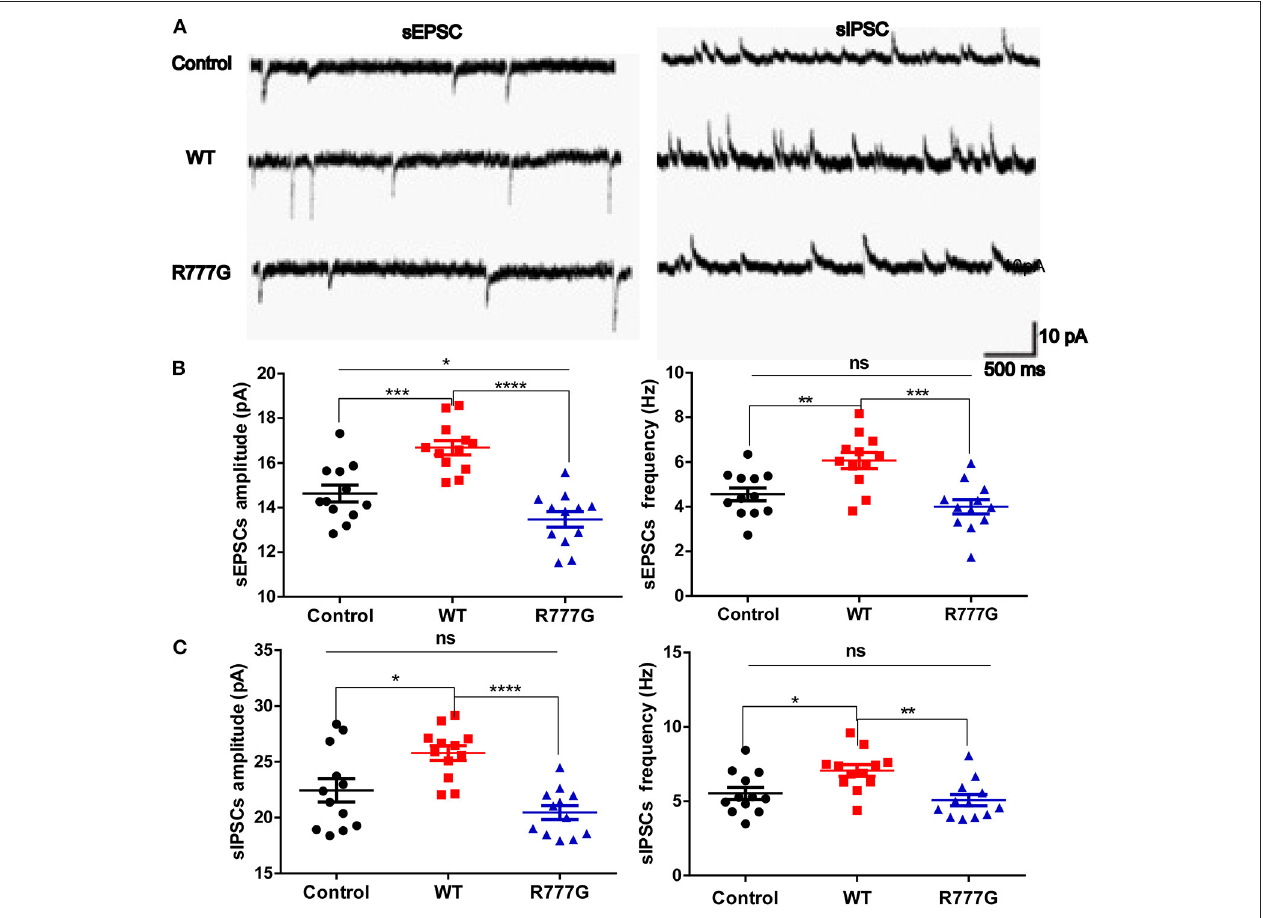
FIGURE 3 | CNTNAP2 R777G affects the post-synaptic currents of neurons. (A) The trace of sEPSCs or sIPSCs. (B) The amplitude and frequency of sEPSC in different groups. (C) The amplitude and frequency of sIPSC in different groups. n = 8 for each group. ANOVA and Bonferroni’s post-hoc test, * p < 0.05, ** p < 0.01, *** p < 0.001, **** p < 0.0001.